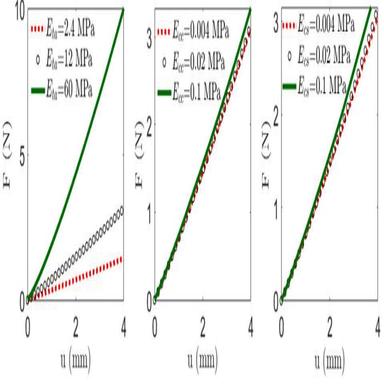
Influence of the mechanical properties of Tunica Albuginea (TA), Corpus Cavernosum (CC), and Corpus Spongiosum (CS) on the overall response of the penis in the plate compression test.